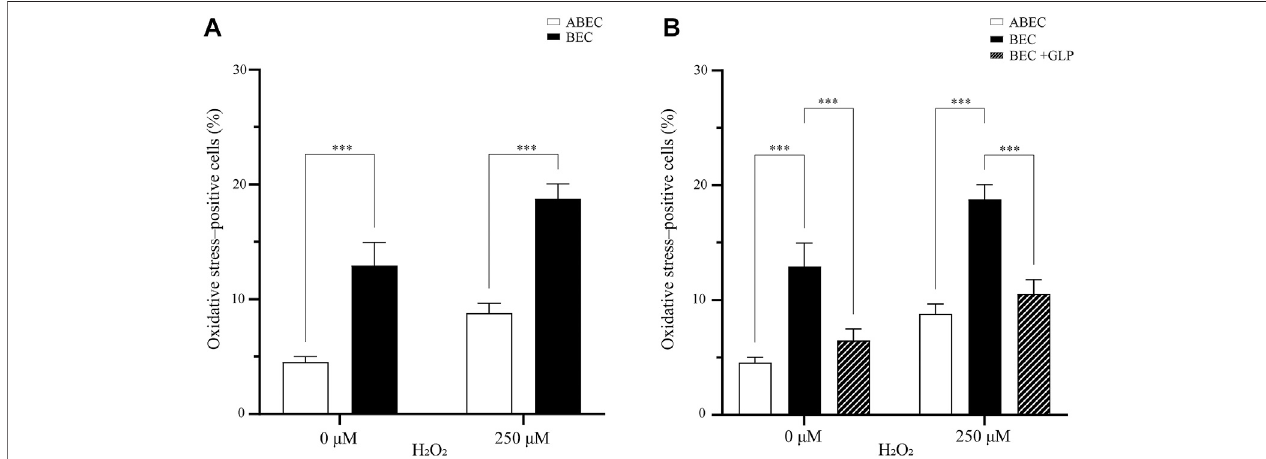
FIGURE4| GLP-1 reduces oxidativestress inthe pseudoislet (A) Including α cells inthe pseudoislet reduces thepercentage ofoxidativestress-positivecellsfrom 13.0 to4.5% in basal conditions and from 18.8 to8.8% upon induction ofoxidative stress by H 2 O 2 (*** p < 0.001) (B) The GLP-1 agonist mimickedthe effectof having α cells present in the pseudoislet devoid of α cells, as it reduced the number of oxidative stress-positive cells from 18.8 to 10.5% (*** p < 0.001). Results are expressed as mean ± SEM, and each data set includes sixteen pseudoislets (n:16), and the experiment was repeated four times (N:4).